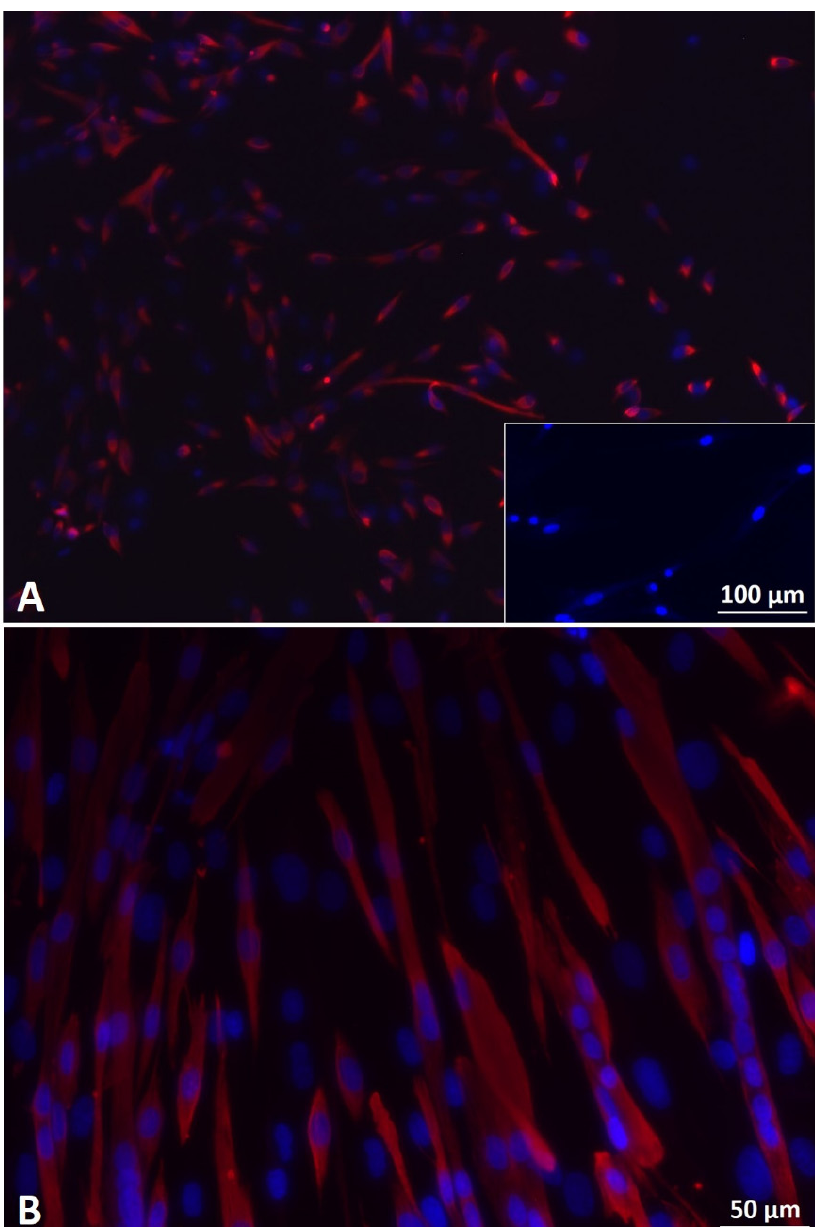
Figure 1. ( A ) Fluorescence microscopy of desmin-positive (red) human primary myoblasts (Mb) in pre-plate 3 (PP3) and passage 4 (P4). Merge with DAPI (blue) shows that nearly all cells were desmin-positive. Insert shows human primary fibroblasts in P9 negative for desmin. Scale bar 100 µm applies to insert as well as to main image. ( B ) Fluorescence microscopy of Mbs in PP3 and P5 after seven days of myogenic differentiation. Merge with DAPI (blue) shows that cells were desmin-positive (red) and formed multinucleated cells, indicating myotube formation. Scale bar 50 µm.